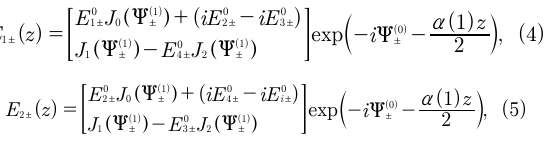
where E ( z ) and E ( z ) are the complex amplitudes 1 ± 2 ±